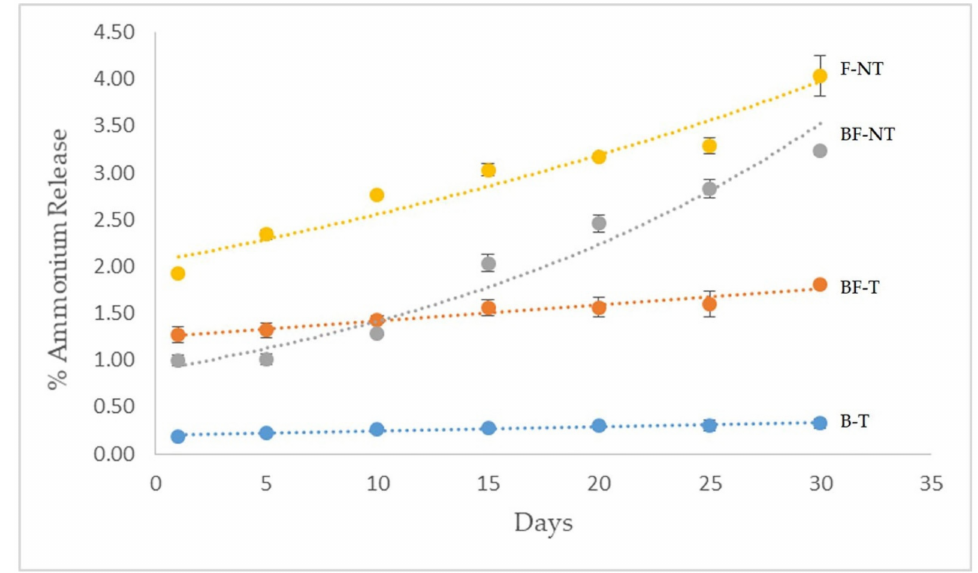
Figure 3. Percent ammonium release of total N applied at five day intervals for 30 days of a water incubation